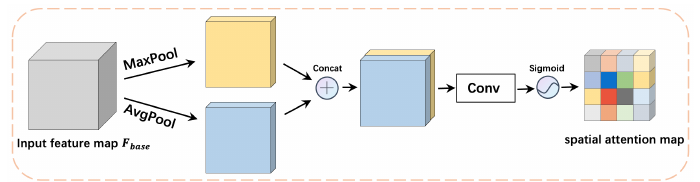
Figure 6. Diagram of spatial attention extractor F sa ()